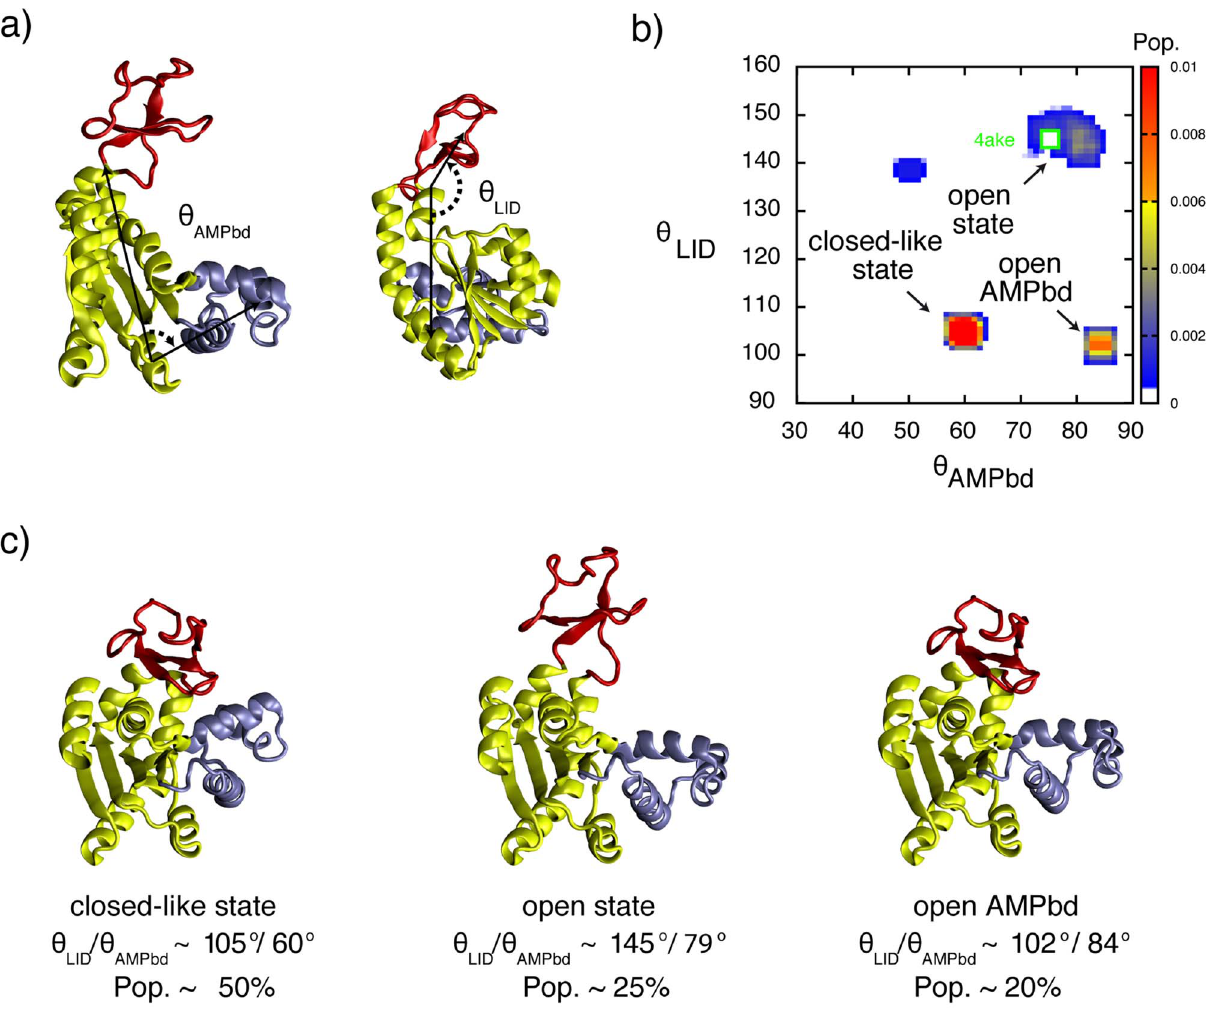
Figure 2. Determination of correlated inter-domain conformational heterogeneity in AK e from RDCs. (A) X-ray structure of substrate free open AK e (pdb code 4ake). The CORE (yellow), LID (red) and AMPbd (cyan) domains are shown. The angles used to describe inter-domain conformational changes (see methods) are shown. (B) Inter-domain orientation distribution for AK e . The robustness of the distributions against various sources of error is discussed in the Supporting Information. (C) Representative conformations for each basin are shown together with angles and their estimated populations; little structural heterogeneity occurs within basins. The uncertainties in the populations due to estimated experimental in the measurements of the RDCs and computational errors are estimated to 10%.